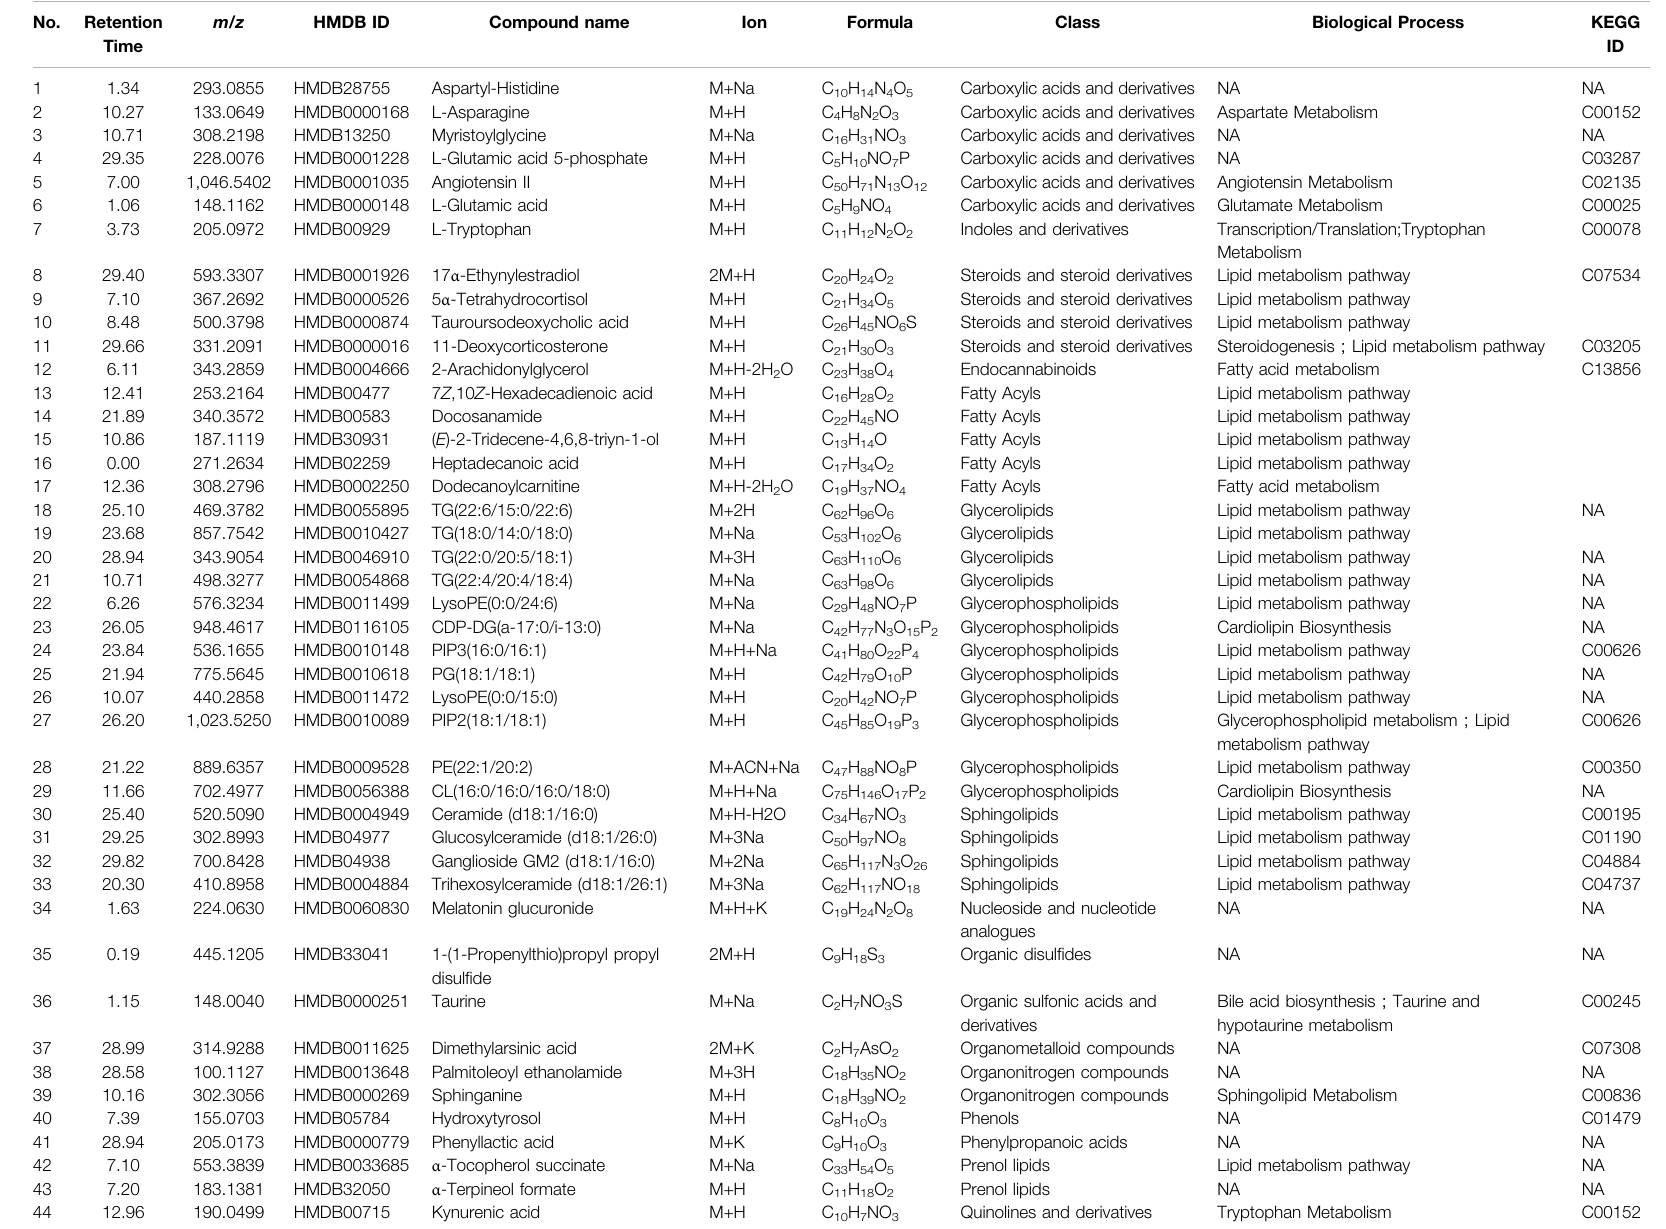
TABLE 4 | Identi fi cation of